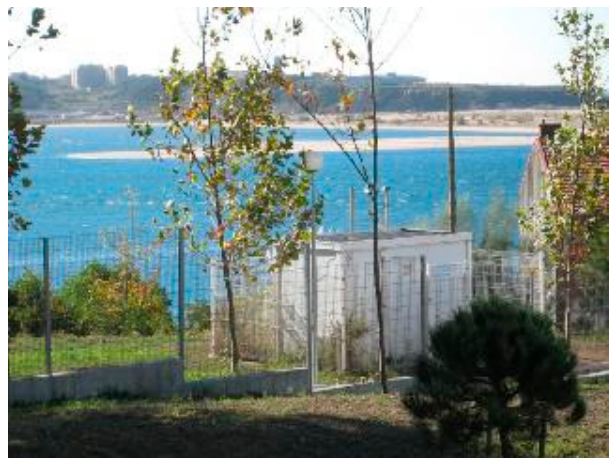
Figure 1. Monitoring site of Sobreiras—Lordelo do Ouro (from http://qualar.apambiente.pt/).